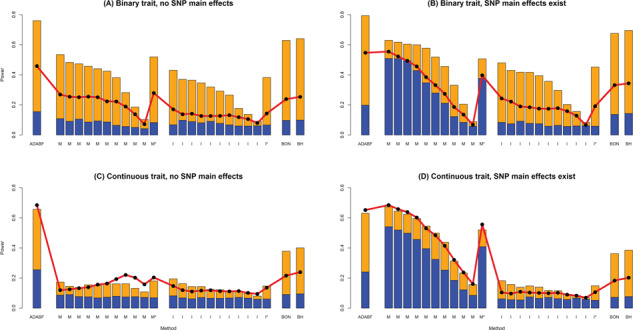
Empirical power given a nominal significance level of 0.05. The empirical power of ADABF, GRS-M (M) and GRS-I (I). GRS-M and GRS-I were evaluated at 10 P-value thresholds (from the left bar to the right bar): 0.0001, 0.00025, 0.0005, 0.001, 0.0025, 0.005, 0.01, 0.025, 0.05 and 0.1. M* and I* are GRS-M and GRS-I corrected for multiple testing, respectively. The P-value of M* (or I*) is 10 times the minimum P-value of the 10 GRS-M (or GRS-I) tests. An M* (or I*) test is claimed to be significant if its P-value < 0.05 (the nominal significance level). BON is single marker analysis while controlling the FWER at 5% using the BON; BH is single marker analysis while controlling the FDR at 5% using the BH. The height of the blue (yellow) bars marks the empirical power of each test given 20 SNP × E with smaller (larger) effect sizes. The red line with black points marks the empirical power given 50 SNP × E with smaller effect sizes.